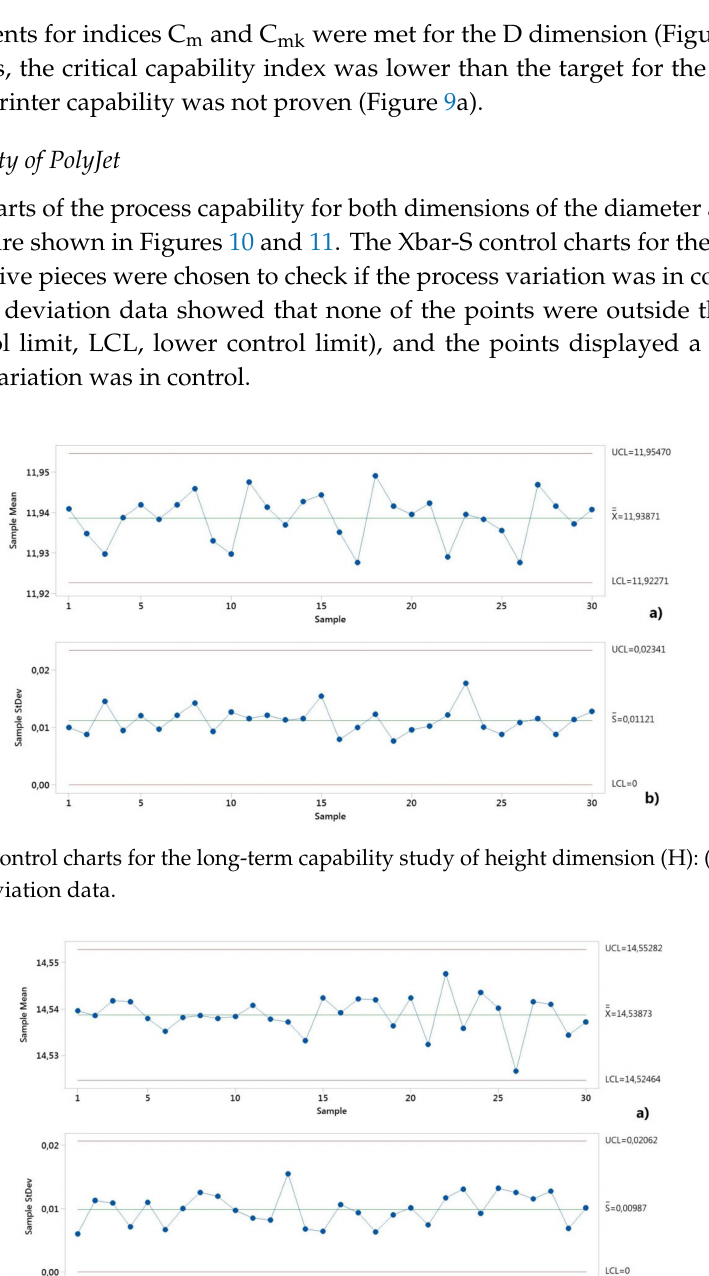
Figure 9. Machine capability analysis report for: ( a ) dimension H; ( b ) dimension D.